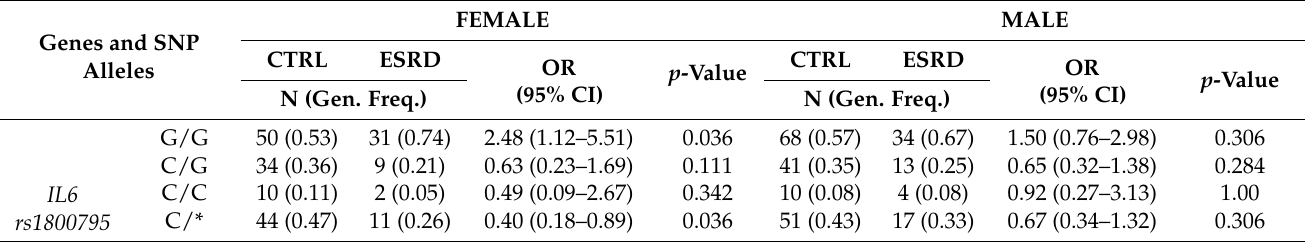
Table 6. Significant SNP genotype frequencies (gen. freq.) in end-stage renal disease patients (ESRD) and controls (CTRL) stratified according to Gender (adjusted by 59 years of age cut-off, diabetes, hypertension, and